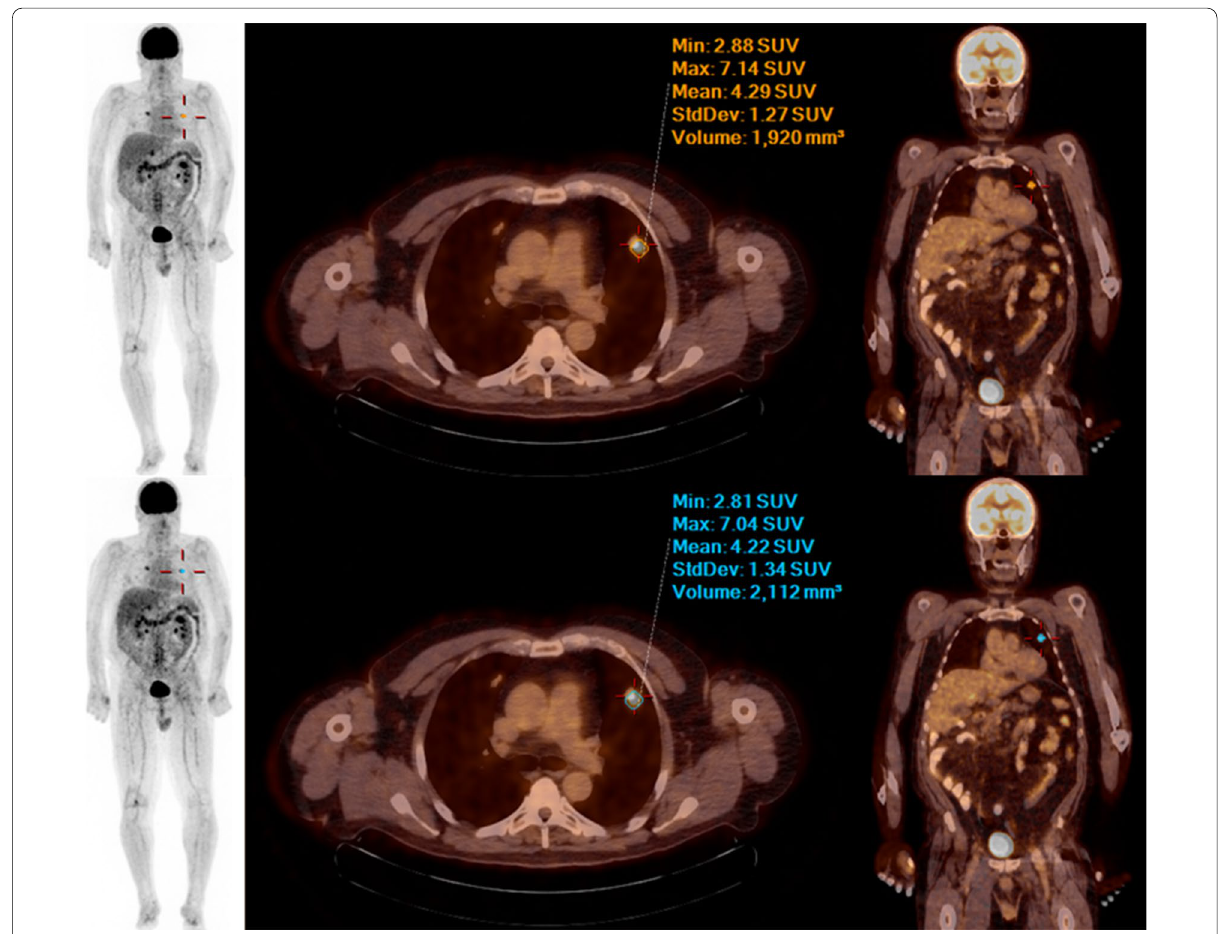
Fig. 2 MIP, fused axial and coronal PET/CT images (from left to right) with 75 s (upper row )and 57 s (lower row) PET acquisition time per bed position of a 63‑year‑old male patient with 94 kg bw suffering from melanoma—no significant difference in image quality, lesion detectability